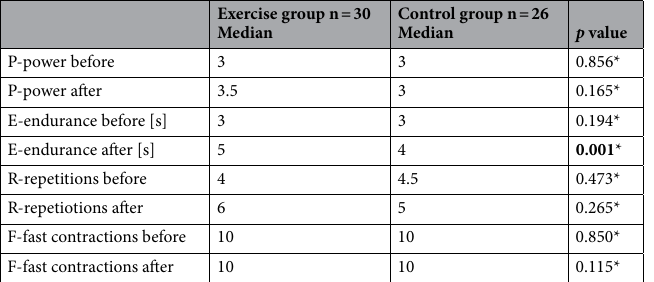
Table 7. Analysis of differences between groups in the assessment of PFM based on the Perfect test. Values statistically significant are in bold. *Mann–Whitney